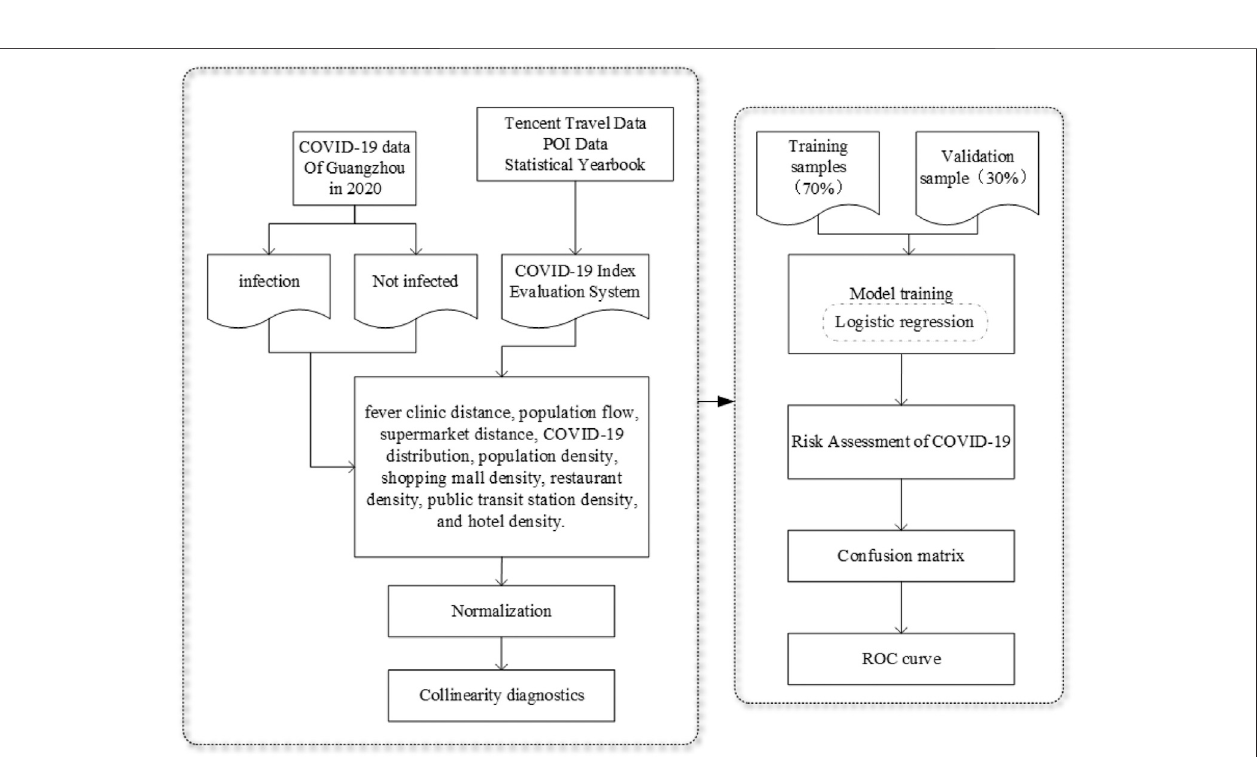
FIGURE 5 | Technical route of the LR model (modeling process and veri fi cation fl ow chart of LR model).